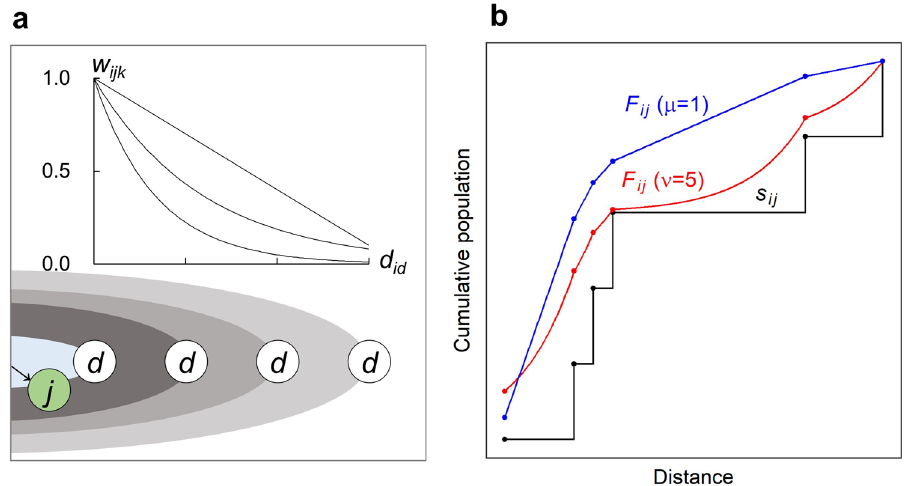
Figure 3. Conceptual illustrations of weighting kernel function and relationship between distance and cumulative population. ( a ) Illustration of weighting kernel function w ijk . ( b ) Comparison among classical intervening opportunities s ij , and two examples of F ij that are newly proposed those including the opportunities of farther areas compared to destination j in the same setting of Fig.